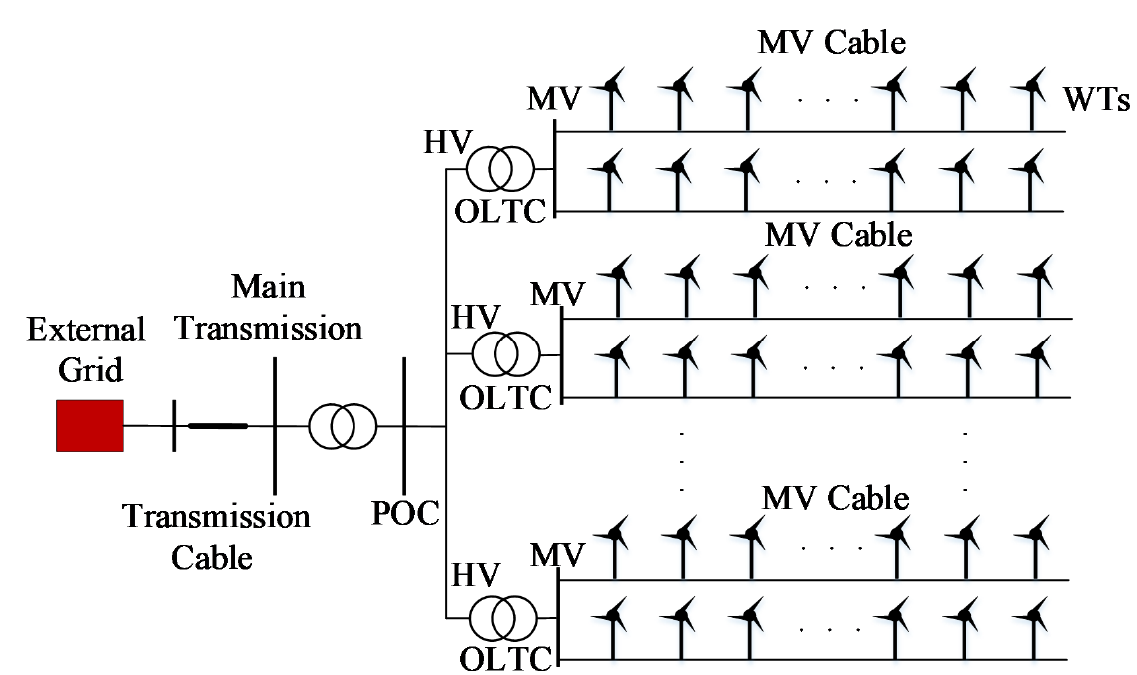
Figure 1. Configuration of a wind farm.